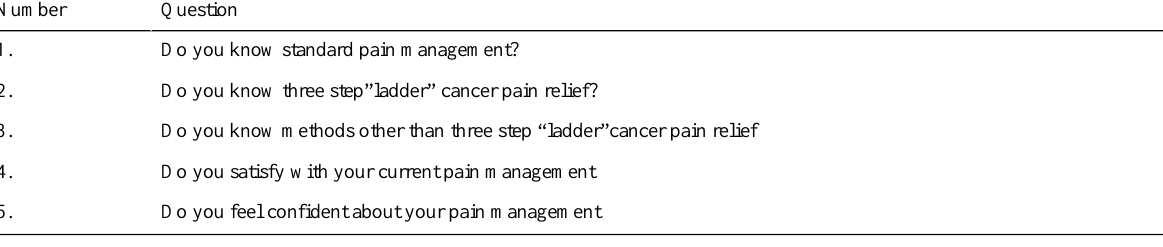
Table 1. Pain management knowledge questionnaire.